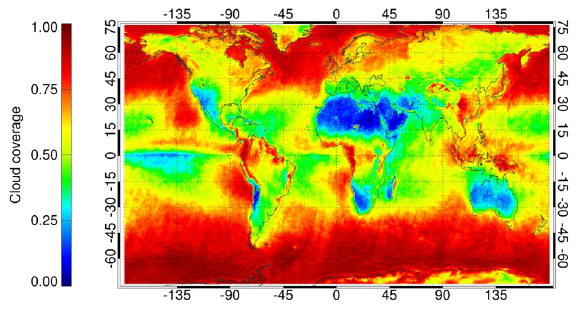
Figure 1. Mean annual cloud coveras observed by the Envisat mission in the years 2007-2009. Image: ESA/Cloud-CCI. produce multi-seasonal images for arbitrary regions of interest. The strengths of the approach are